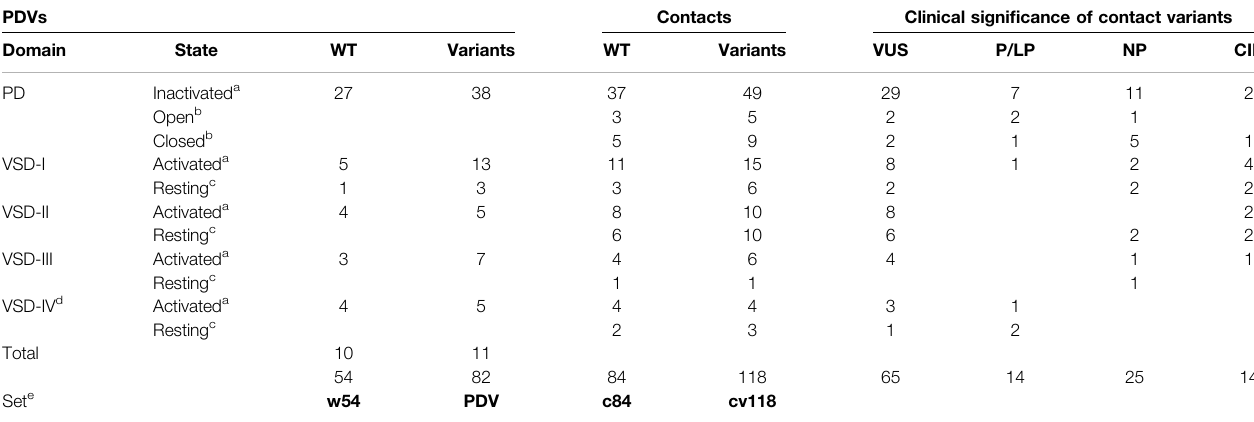
TABLE 7 | Domain distribution of PDVs and their contact variants. PDVs